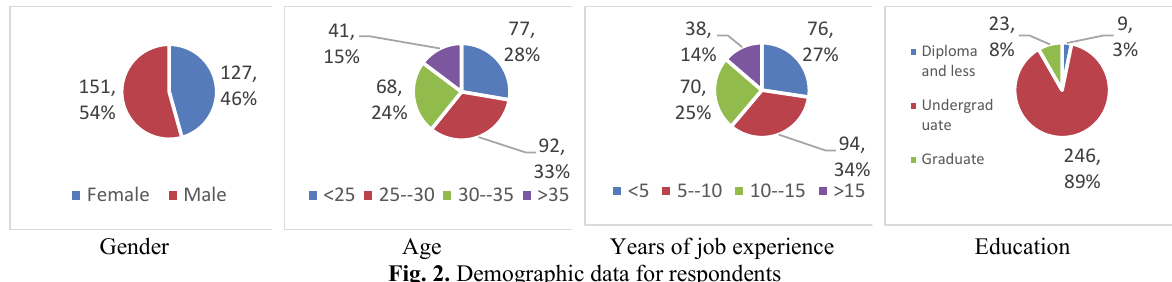
Fig. 2. Demographic data for respondents